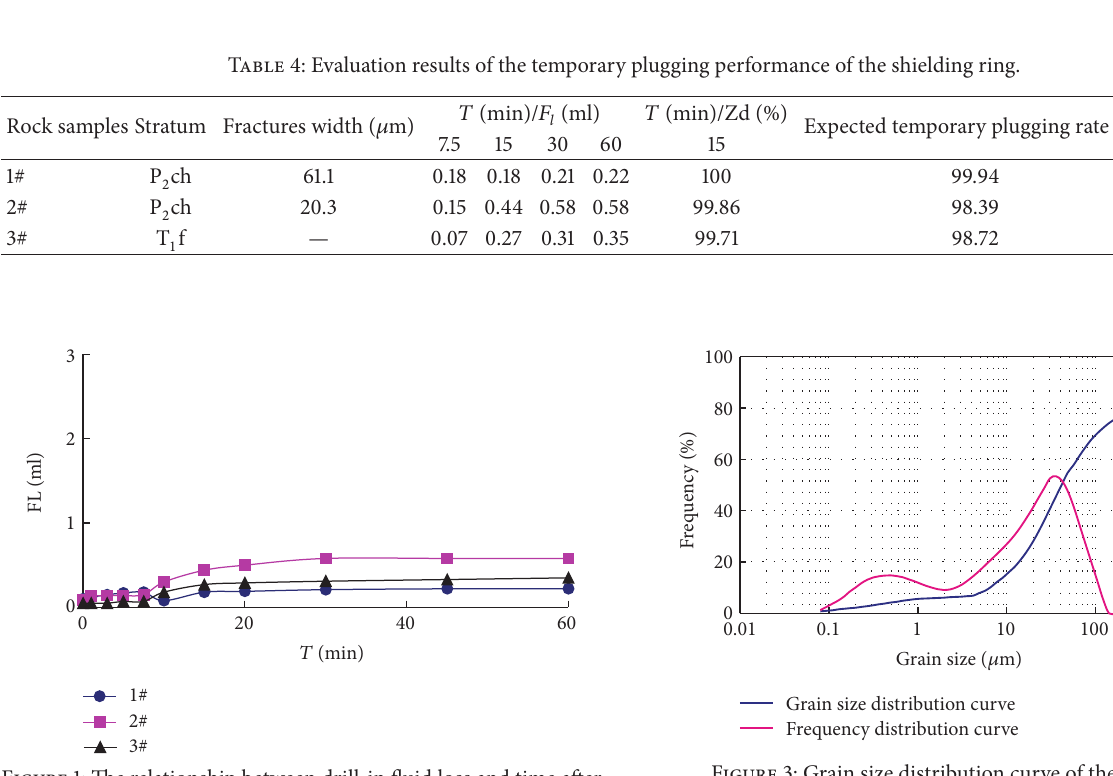
Figure 3: Grain size distribution curve of the